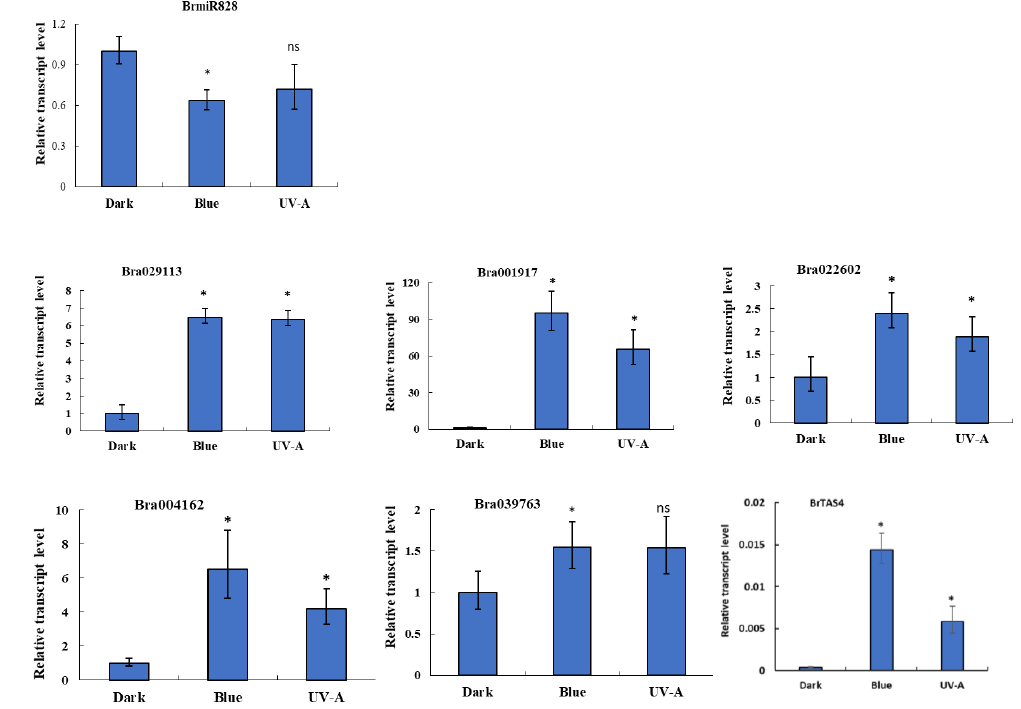
Figure 5. Relative expression of BrmiR828 and its candidate targets in seedlings of Brassica rapa with dark, blue, or UV-A light treatment was detected by qRT-PCR and calculated with 2 − ∆∆ CT . The ubiquitin ( UBQ ) gene served as the internal control to correct for template quantity. Each bar indicates the mean ± SE of three biological replicates assays after correcting for template quantity relative to the UBQ gene. Statistically significant di ff erences between blue light treatment and dark, UV-A treatment and dark are shown ( t -test, * p < 0.05; ns, not significant di ff erence, df = 3)